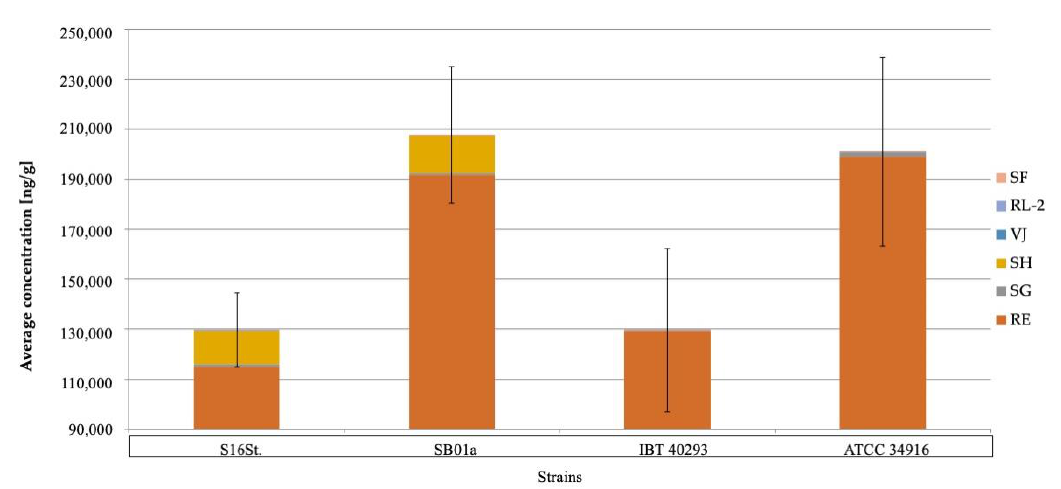
Figure 2. Shows the total amount of macrocyclic trichothecenes (MCT) detected on PDA for every strain since this was the nutrition medium with the highest amounts of MCT. In PDA, strains S16St. and IBT40293 produced significantly ( p < 0.05) fewer toxins than the other two strains. The total concentration of macrocyclic trichothecenes of four different Stachybotrys chartarum genotype S strains on potato-dextrose-agar (PDA). RE: roridin E; RL-2: roridin L-2; SF: satratoxin F; SG: satratoxin G; SH; Satratoxin H; VJ: verrucarin J; Stl.: stachybotrylactam.